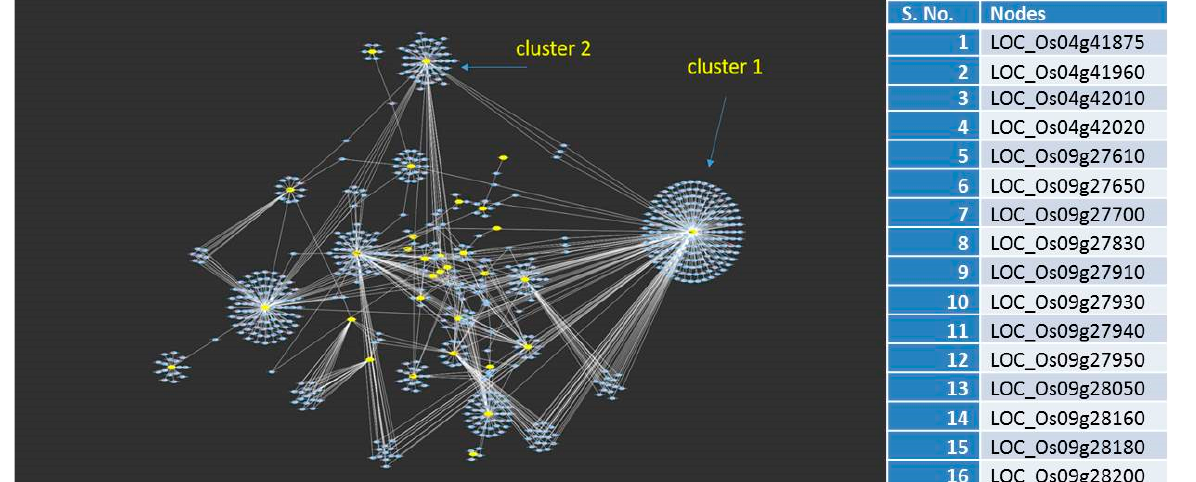
Figure 4. Network analysis of the candidate genes present in the selected QTL regions on chro- mosomes 4, 5, and 9 identified using recombinant inbred lines developed from N22/IR64. The 16 nodes obtained from the network analysis are presented in the right panel.